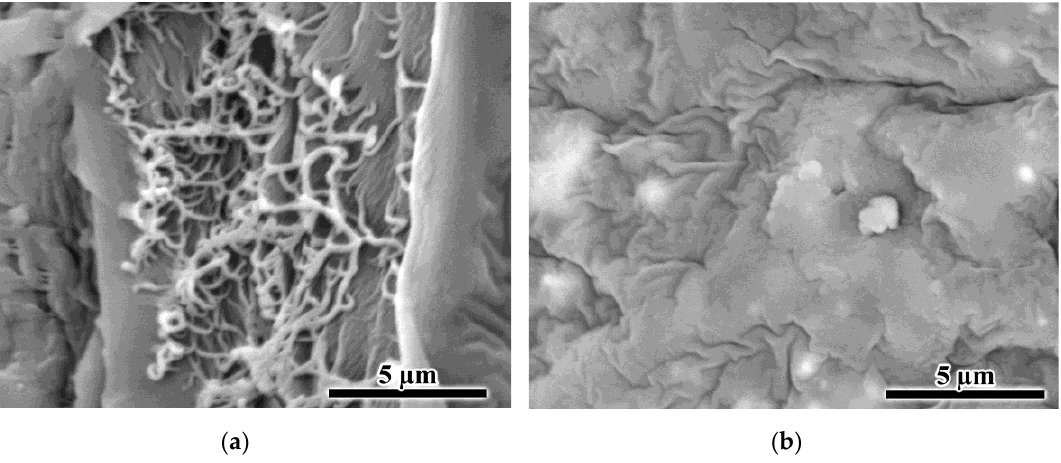
Figure 10. SEM images of the porous formations in the center ( a ) and at the edges ( b ) of the film obtained from the 30% polylaurolactam solution by precipitation with isopropanol.